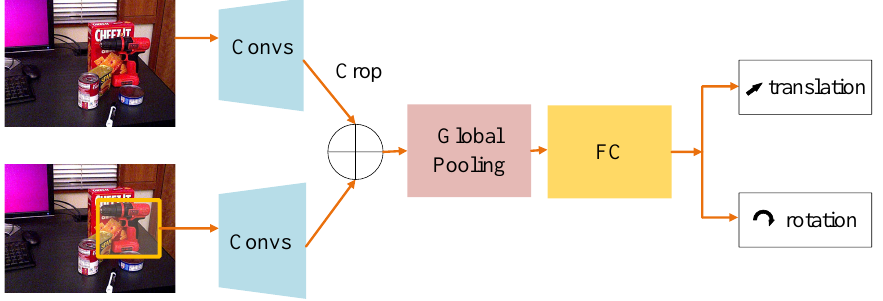
Figure 4. The Architecture of Pose Regression Module. The inputs of this module are the original im- age and the Region of Interest (ROI) of the image. Convs is ResNet18. The plus sign is concatenating operation. We use a global pooling to integrate information. A Fully Connected layer (FC) is used to regress 6D